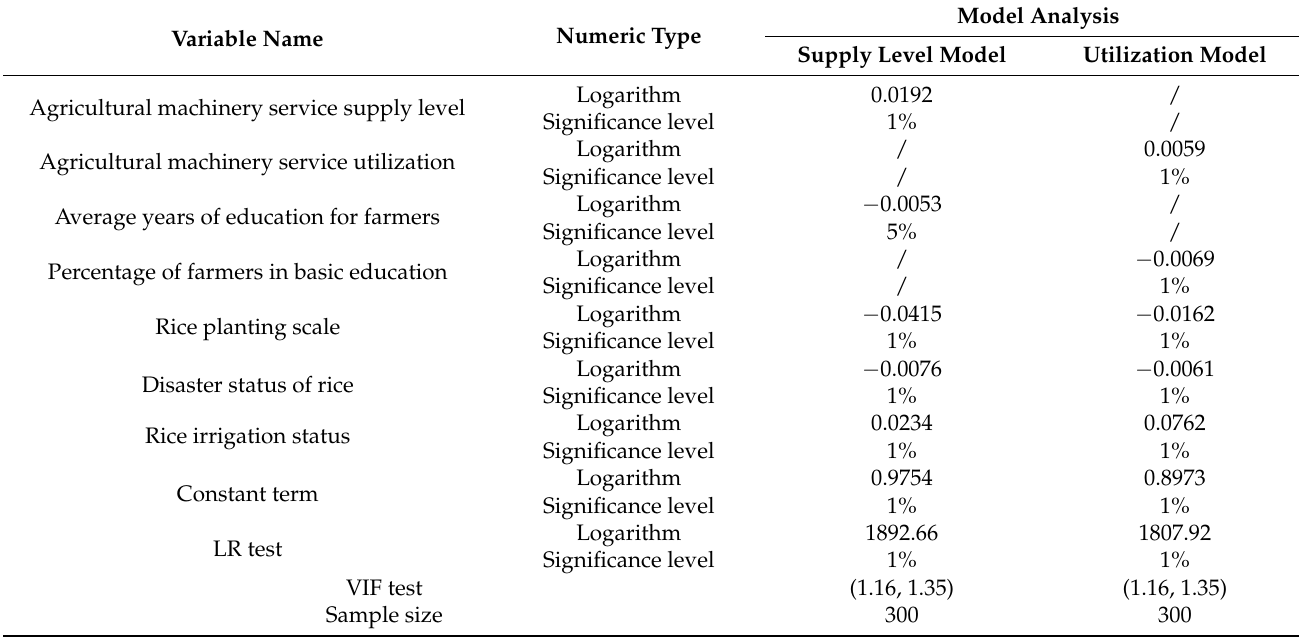
Table 6. Data analysis of rice crops.